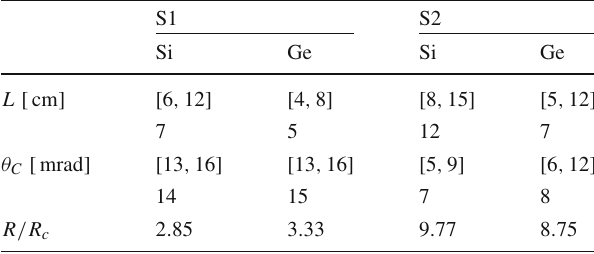
Fig. 10 Regions of minimal uncertainty of d - and g -factors as a func- tion of the crystal parameters L and θ C , for (left) Si and (right) Ge in (top) S1 and (bottom) S2 scenarios. The markers and continuous (dotted) lines represent the minimum uncertainty and regions whose uncertainties on d ( g ) are increased by 20% with respect to the mini- mum, respectively Table 2 Bent crystal parameters for Si and Ge optimized using charm baryon decays, for the two possible experimental scenarios under con- sideration. The intervals give approximate regions whose uncertainties on the d factor are increased by 20% with respect to the minimum, whereas the central values are chosen for the sensitivity studies dis- cussed in Sect. 6